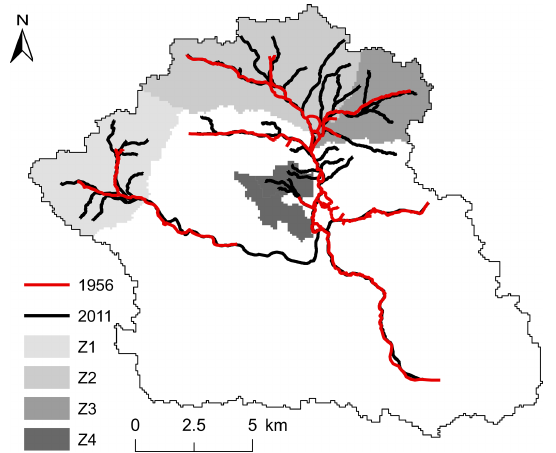
Figure 4. Identification of the four subwatersheds (grey shades) which display the largest changes between the drainage network in 1956 (red line) and in 2011 (black line).